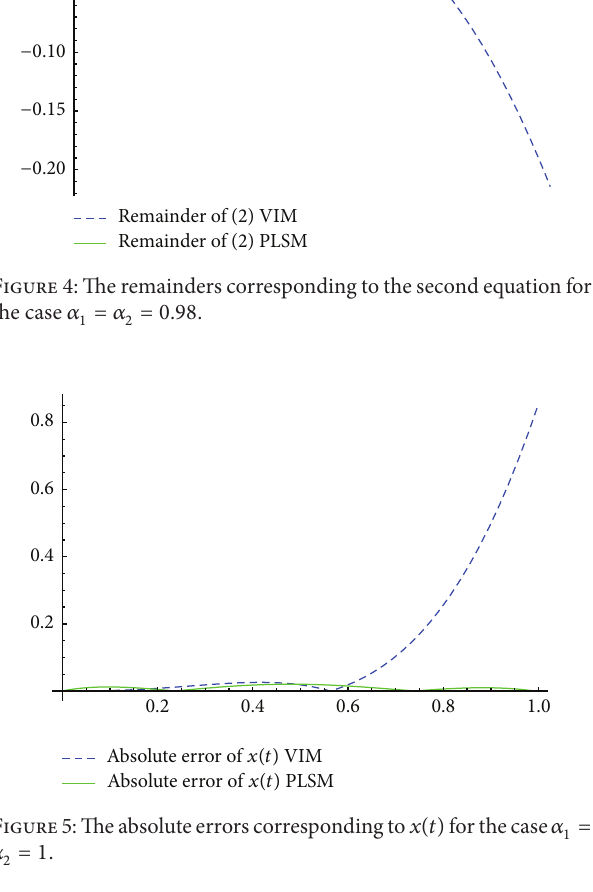
Figure 5: The absoluteerrors corresponding to 𝑥(𝑡) forthe case 𝛼 1 = = 1 . 𝛼 2